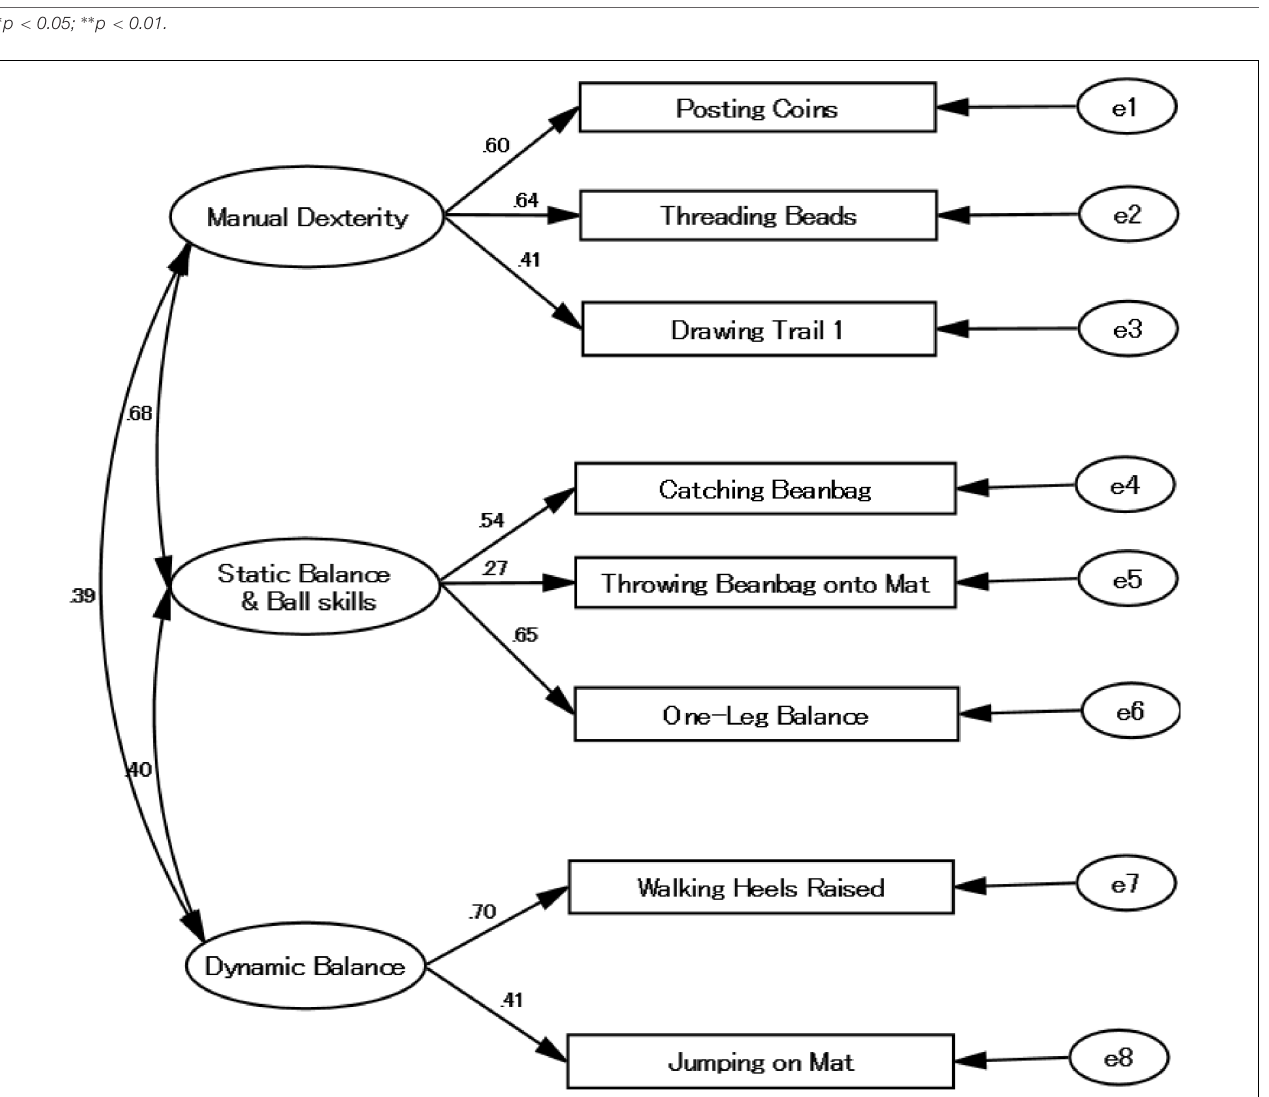
FIGURE 2 | Modified three-component model of MABC-2 for